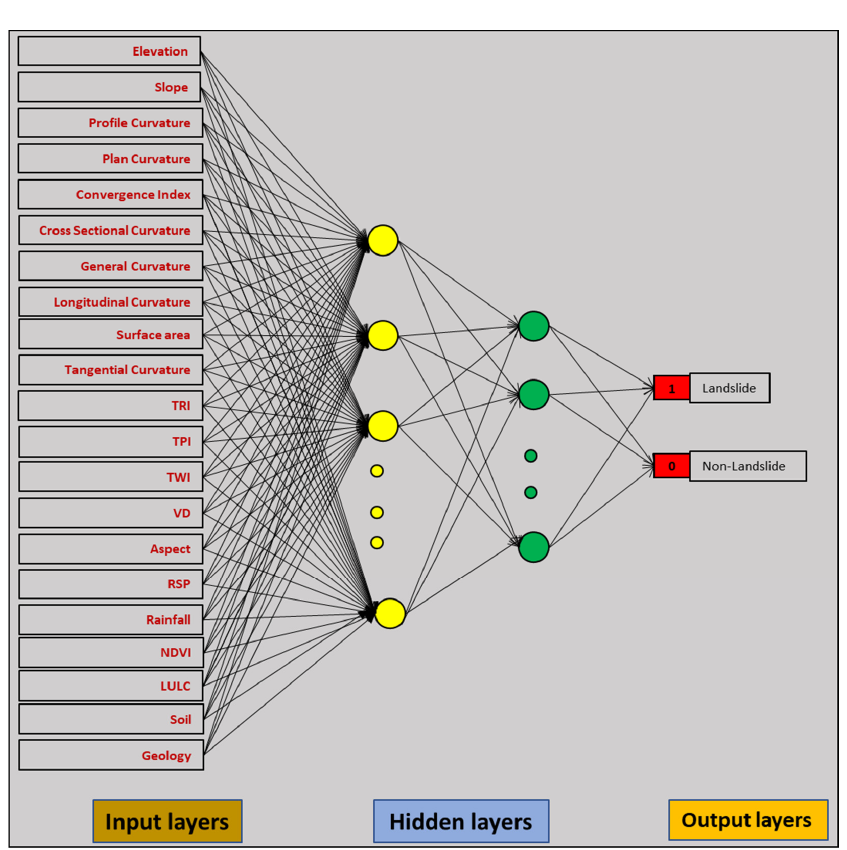
Figure 6. Structure of the ANN model for the present study.